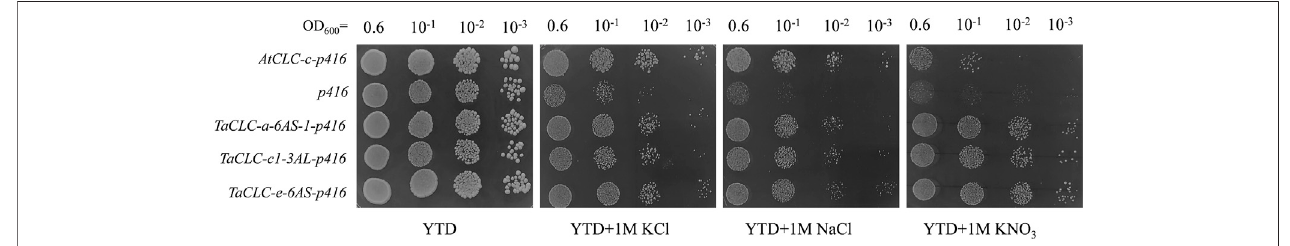
FIGURE8| Yeast Δ gef1 mutantcomplementationexperiment.Yeasttransformedwithemptyvector(p416)wasusedasanegativecontroland AtCLC-c wasused asapositivecontrol.ThetestedYTD(1%yeastextract/2%tryptone/2%dextrose)mediasupplementedwithdifferentconcentrationsofcompounds(1 MKCl/1 MNaCl/ 1 M KNO 3 ) are indicated under each panel. Serial dilutions (10 − 1 ) of yeast culture were